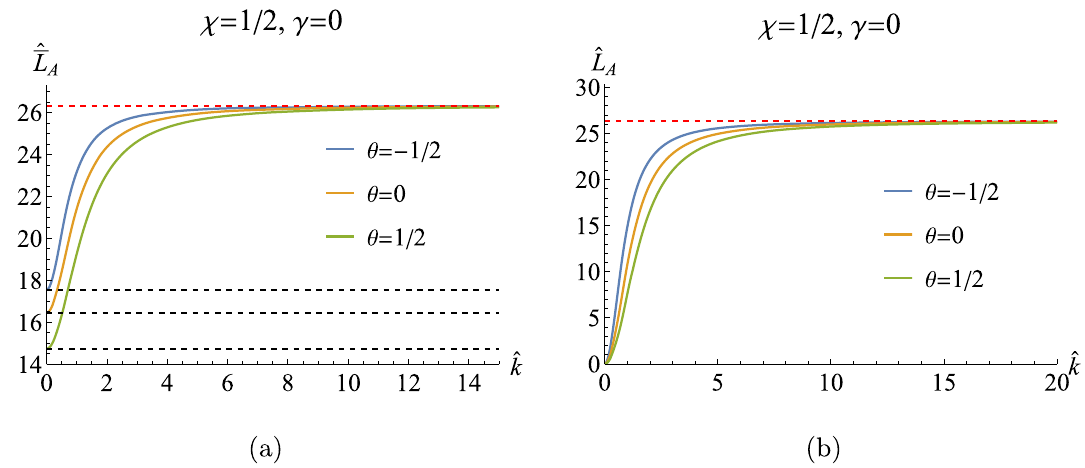
ˆ¯ Fig. 7 The Lorentz ratios ˆ L A and L A as a function of ˆ k for the holographic two-currents model. The red dashed line represents the upper bound established by the limit ˆ k (cid:10) 1, while the black dashed line represents the lower bound set by the limit ˆ k (cid:9) 1